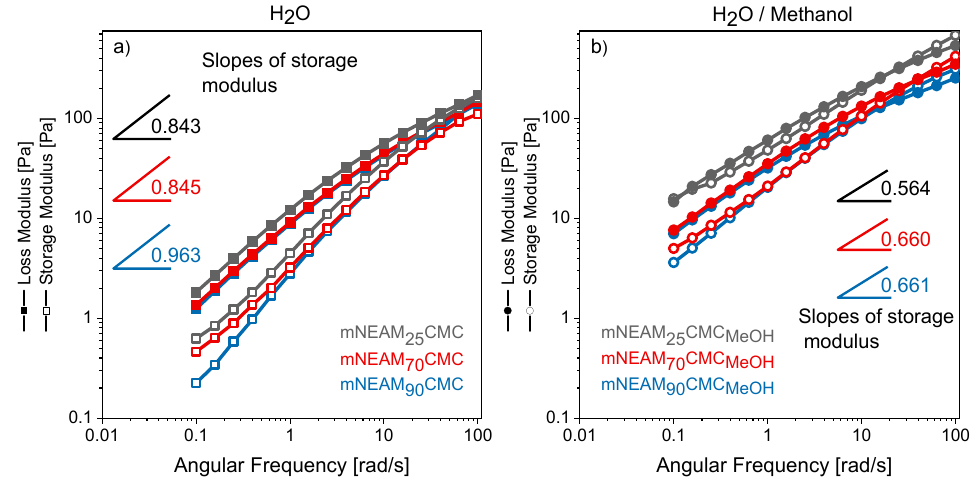
Figure 5. Mechanical spectra for blends prepared in water ( a ) and water/methanol ( b ).